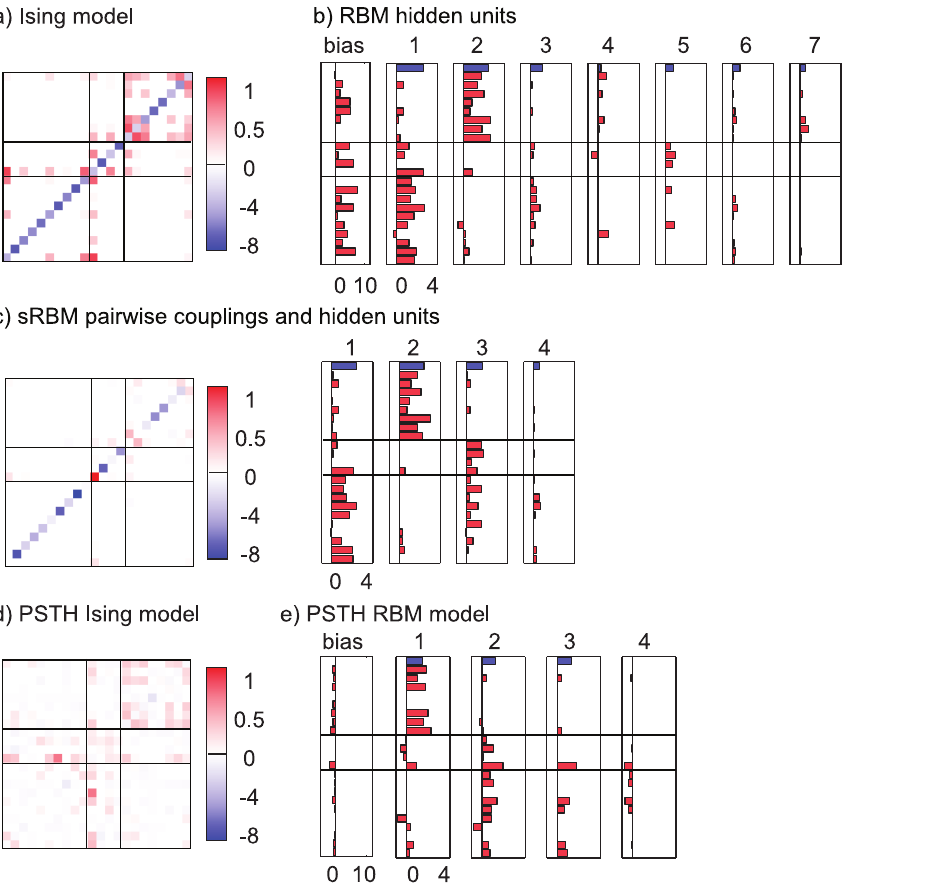
Figure 2. Functional connectivity patterns of the three models estimated for recording session B4. The horizontal lines indicate approximate boundaries between cortical layers II/III, layer IV and layers V/VI. ( a ) Ising model coupling matrix. Each row/column of the matrix corresponds to a neuron, bias terms are shown on the diagonal. The model has many small coupling terms that encode positive correlations. ( b ) The RBM coupling weights are shown as a bar chart for each hidden unit, ordered from left to right from largest to smallest activity. The first bar chart is the bias for all the visible units, and the blue bar at the top of each plot corresponds to the bias of that hidden unit. Blue bars indicate negative values (the bias terms are predominantly negative, but plotted with flipped sign to fit on the scale of the remaining terms). ( c ) The sRBM weights are shown in the same way, with the pairwise couplings on the left and hidden units on the right. The pairwise connections are qualitatively very different from those of the Ising model, as most of the structure is better captured by hidden units. ( d ) Pairwise coupling terms for the Ising model with stimulus terms. Much of the structure, in particular the bias terms, have been explained away by the stimulus terms. ( e ) Hidden unit couplings for the RBM with stimulus terms. The structure of the hidden units remains largely unchanged, indicating higher-order couplings are due to network interactions and not stimulus correlations.